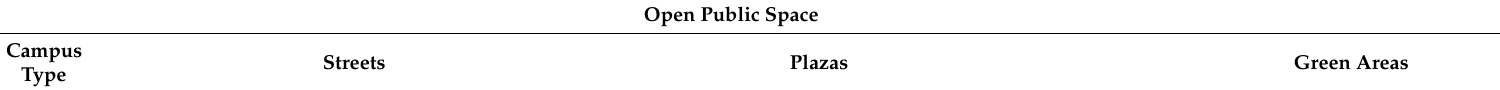
Table 4. Public space classification of Dutch campuses, based on Carr et al. [59], Oldenburg [61], Carmona [43,44], van Melik [111] and Lee